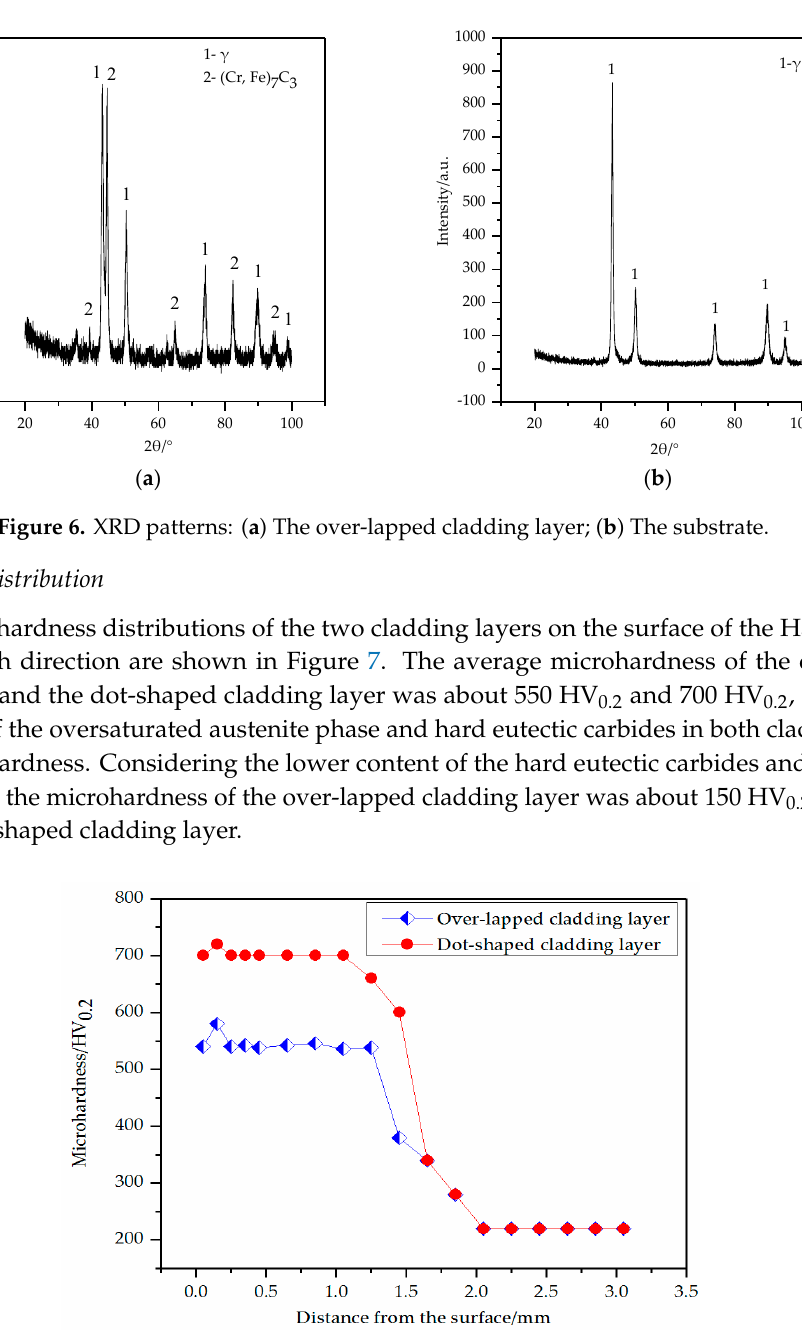
Table 3. EDS analysis of the four points in Figure 5 (at.%).